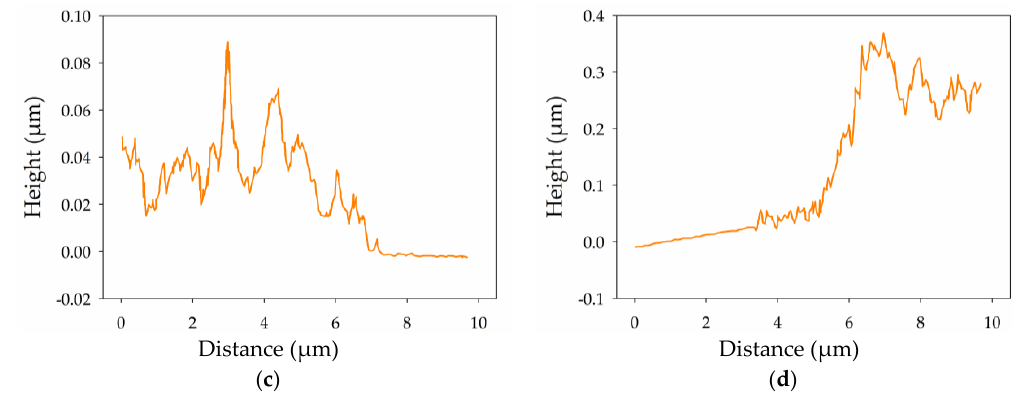
Figure 2. Atomic force microscopy topographic and depth profiling data for ( a , c ) thin and ( b , d ) thick MWCNT films transferred onto silicon; ( a , b ) 5.0 µm × 5.0 µm height topography images and ( c , d ) average line plots for 1.0 µm × 9.5 µm cross-sections showing film height at a boundary region.